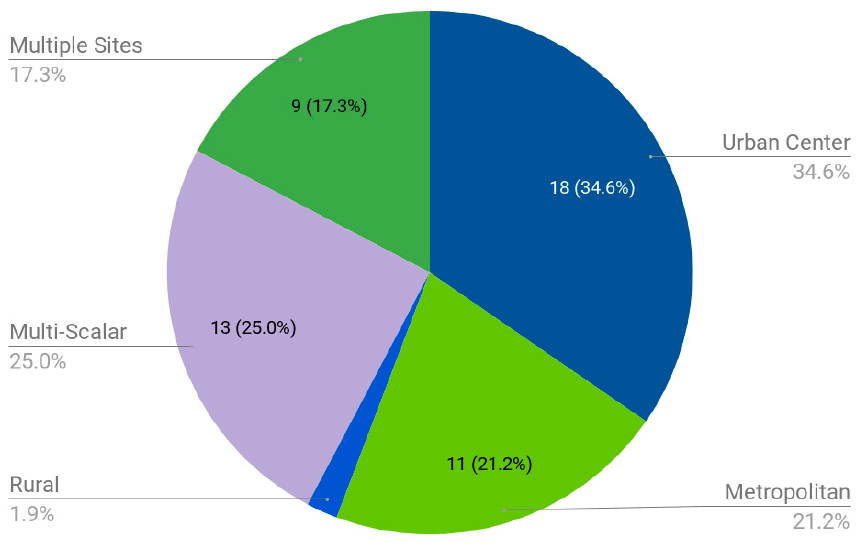
Figure 3. Distribution of urban greenway studies by extent.